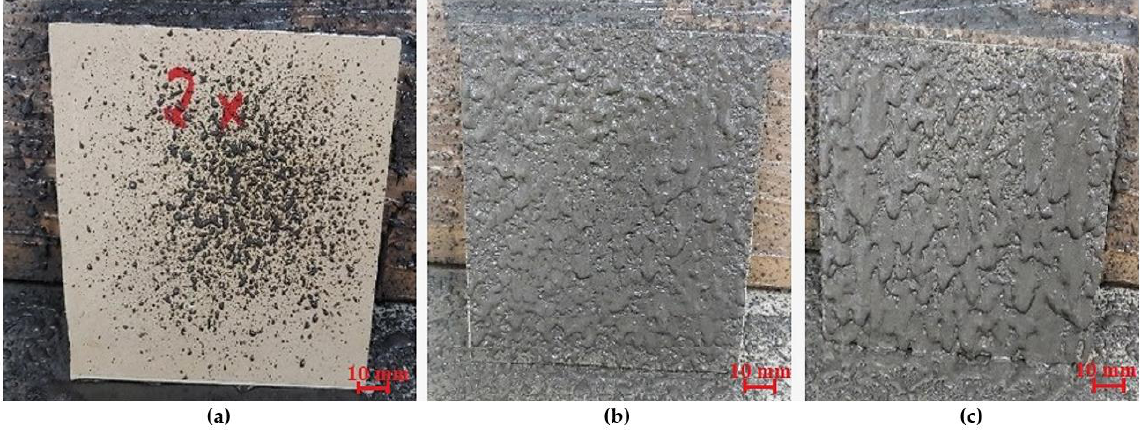
Figure 2. Geopolymer layer using a spray nozzle: ( a ) with a diameter of 4 × 10 −3 m, ( b ) with a diameter of 6 × 10 −3 m, and ( c ) with a diameter of 8 × 10 −3 mm.